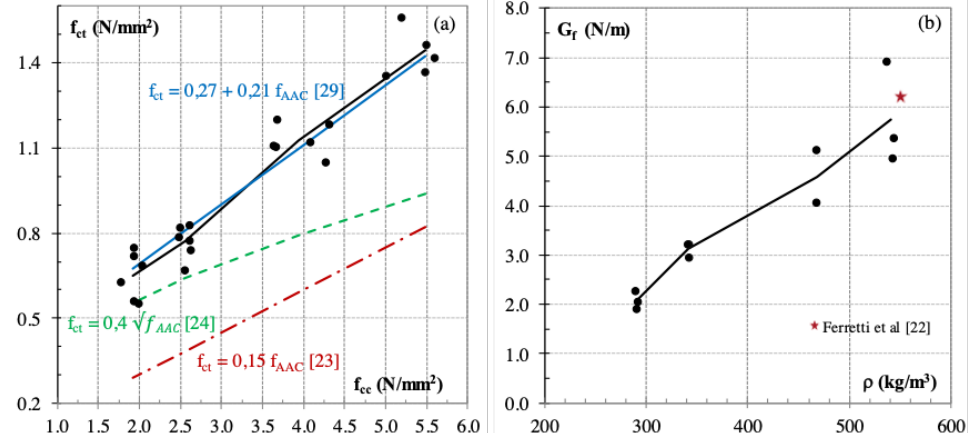
Figure 5. (a) Comparison between experimental data and analytical relations available in the literature in terms of flexural tensile strength f ct vs. cube compressive strength f cc ; (b) experimental relation between fracture energy G f and density ρ , for a moisture content of (6 2) ±